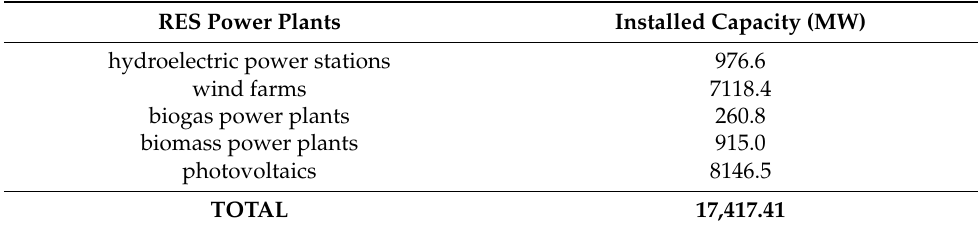
Table 1. The capacity of RESs in Poland.